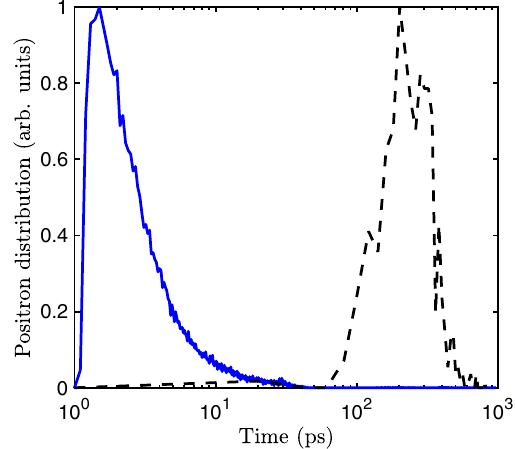
FIG. 8. Positron temporal distributions obtained with FLUKA at the target back surface (blue solid line) and after the dogleg (dashed black line).